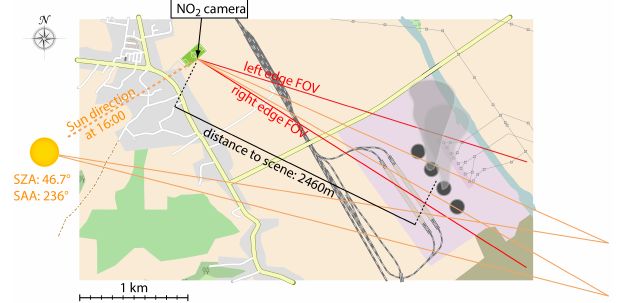
Figure 4. Observational geometry during the AROMAT-2 cam- paign at Turceni’s power plant. The NO 2 camera was installed on a football pitch looking at the four 280m tall stacks. The red lines delimit the camera horizontal FOV (6 ◦ ). The direction of the Sun at 16:00 local time is approximately indicated, together with two rays illustrating the scattering behind the scene towards the camera. One of the rays passes through the plume, while the other one passes by. Map data from